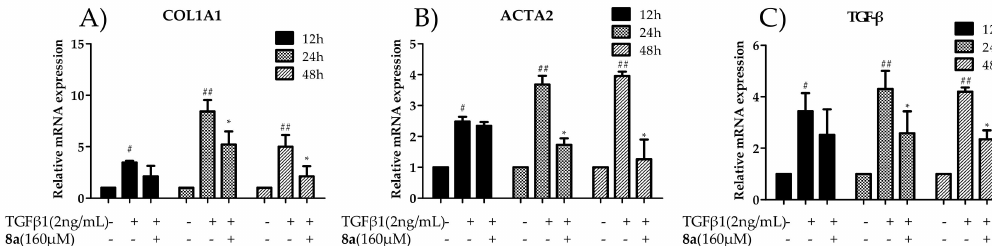
Figure 3. E ff ects of compounds 8a on inhibiting COL1A1 (A), ACTA2 (B), and TGF β (C) mRNA levels in LX-2 cells after the treatment of 8a (160 µ M) for 12 h, 24 h and 48 h. The data were analyzed by real-time PCR and presented as the mean ± SEM, (#) p < 0.05, (##) p < 0.01 as compared to that of the control group; (*) p < 0.05, (**) p < 0.01 as compared to that of TGF- β 1 group. The mRNA expression levels were normalized against